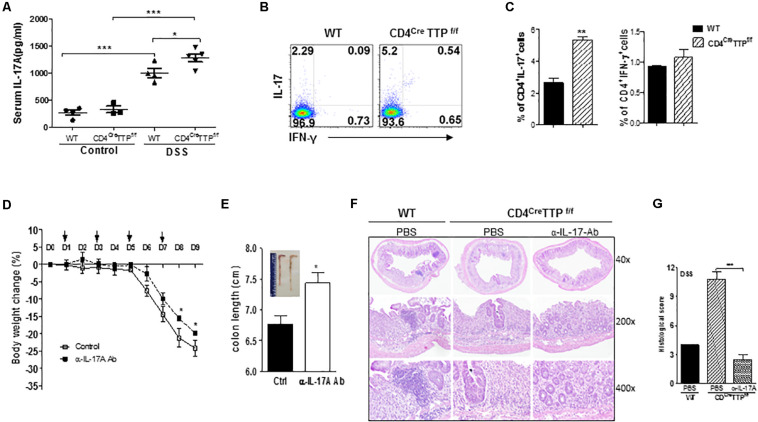
IL-17 mediates DSS-induced colitis in the T cell-specific TTP conditional knockout mice. Wild-type and CD4CreTTPf/f mice were fed 2.5% DSS water for 5 days and then switched to normal water for additional 4 days. Serum was isolated at day 9 and used to measure IL-17A levels by ELISA (A). Lymphocytes isolated from mesenteric LN at day 9 were analyzed for intracellular cytokine expression by flow cytometry gated as CD4+ T cells (B,C). CD4CreTTPf/f mice were received 150 mg of IL-17A–specific neutralizing mAb (InVivoMAb anti-mouse IL-17A, clone 17F3; BioXcell) intraperitoneally every other day starting on day 1 after DSS water administration. (D) Average body weight of the mice at indicated time points. (E) At day 9, colons were photographed (insert) and individual colon lengths were measured. (F) Sections of colons were analyzed with hematoxylin and eosin staining. (G) Histological scores of colons collected from the above mice. Data are from four or five mice per group and represented as mean ± SD. *p < 0.05, **p < 0.01, and ***p < 0.001 between groups.